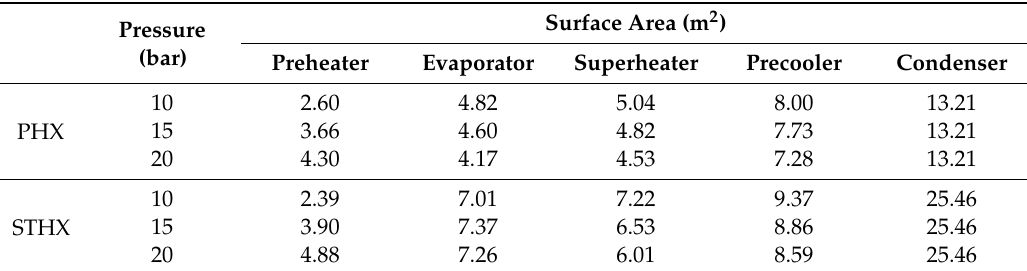
Table 3. Surface areas for each component of the PHXs and STHXs with evaporator pressures of 10, 15 and 20 15 and 20 bar.